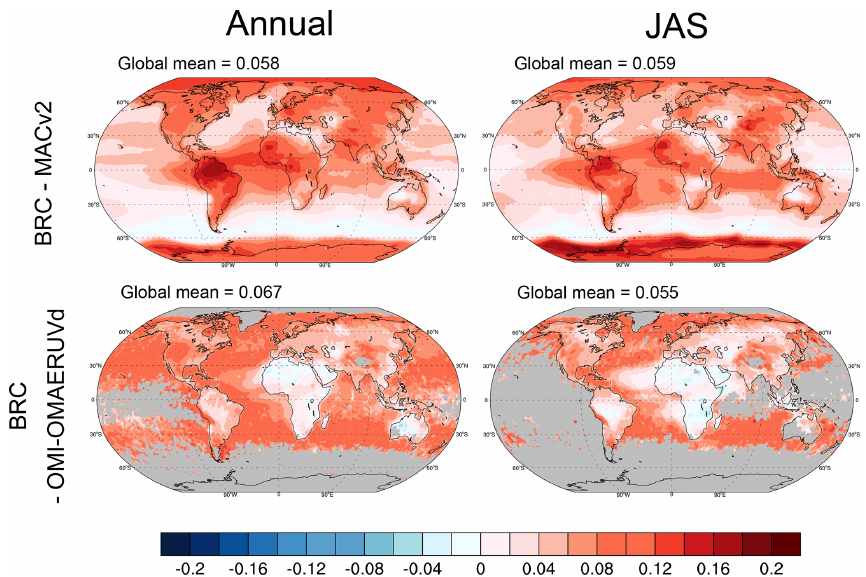
Figure A3. SSA (350nm; see Tables 2 and 3 for details) difference between the BRC simulation and MACv2 and OMI-OMAERUVd averaged over the year and over the months of July, August, and September (JAS). Shaded areas indicate a missing value.